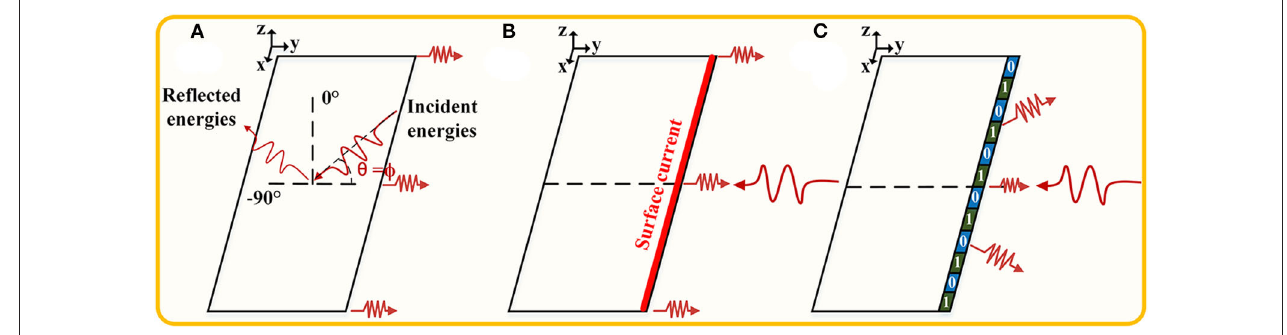
FIGURE 1 | Suppression of edge scattering. The plane waves illuminate a rectangular metal surface. (A) Scattering pattern at an oblique incident angle of θ = φ (0 ◦ < φ < 90 ◦ ). (B) Edge back-scattering under horizontal polarization at the incident angle of θ = 90 ◦ . (C) The schematic of coding metasurface purfle used to suppress edge